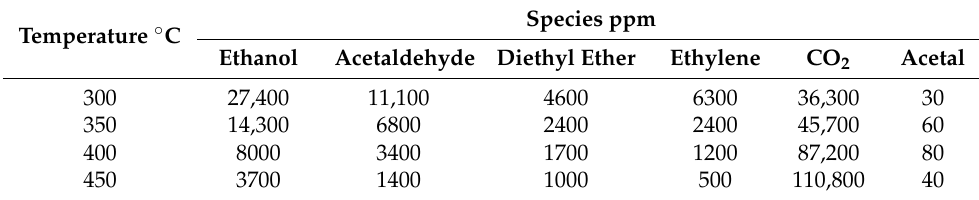
Table 2. Species formed in temperature-programmed oxidation measurement.